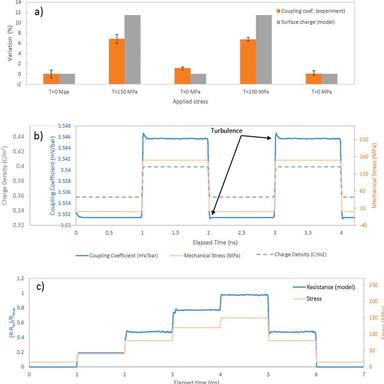
Finite element modeling results on the piezoelectric sample (see). (a) Compares the variation of the surface charge calculated by the model with the experimental coupling coefficient under different stress conditions. The results reveal a strong correlation between the electrokinetic response, applied stress, and the surface charge. (b) Illustrates the effect of mechanical stress on surface charge and mechanical stress calculated by the model. Consistent with the experimental observations, turbu